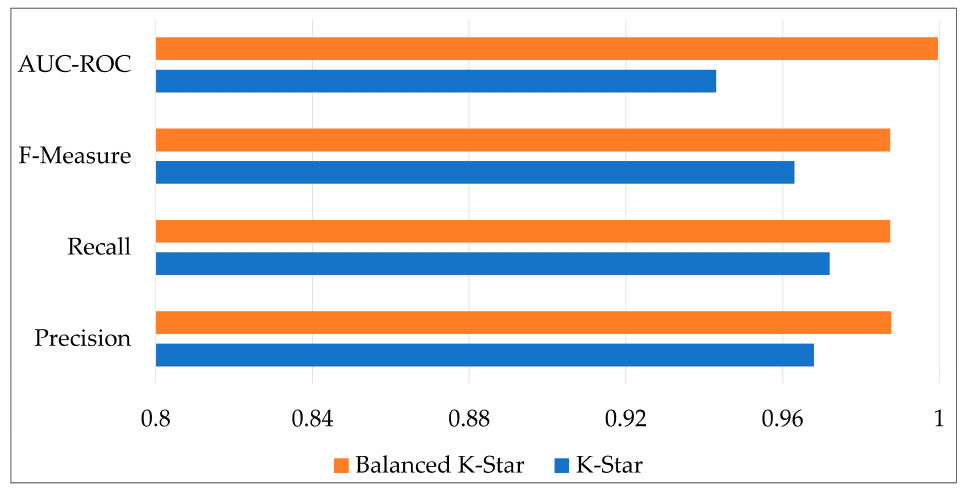
Figure 3. Comparison of standard K-Star and the proposed Balanced K-Star in terms of the precision, recall, F-measure, and AUC-ROC metrics.